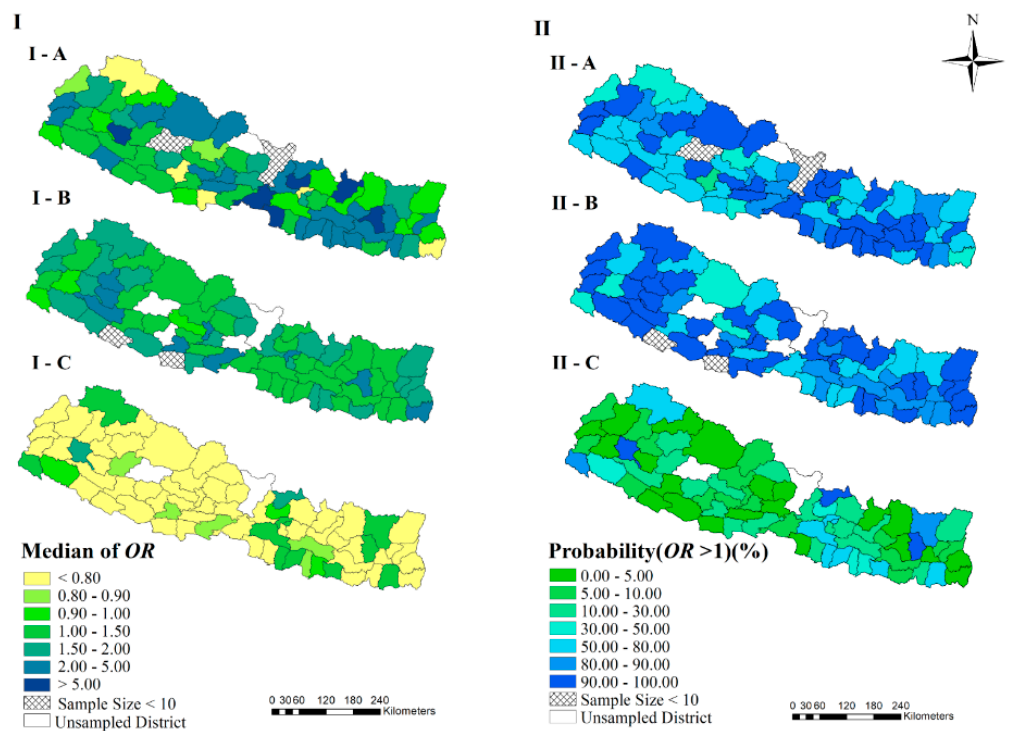
Figure 3. The estimated relative risk ( OR ) of districts, compared with the country-level risk in 2016. (I-A), (I-B) and (I-C) indicate the median of posterior distribution of OR in the survey years 2006, 2011 and 2016, respectively. (II-A), (II-B) and (II-C) represent the probability of OR larger than one in the survey years 2006, 2011 and 2016, respectively.